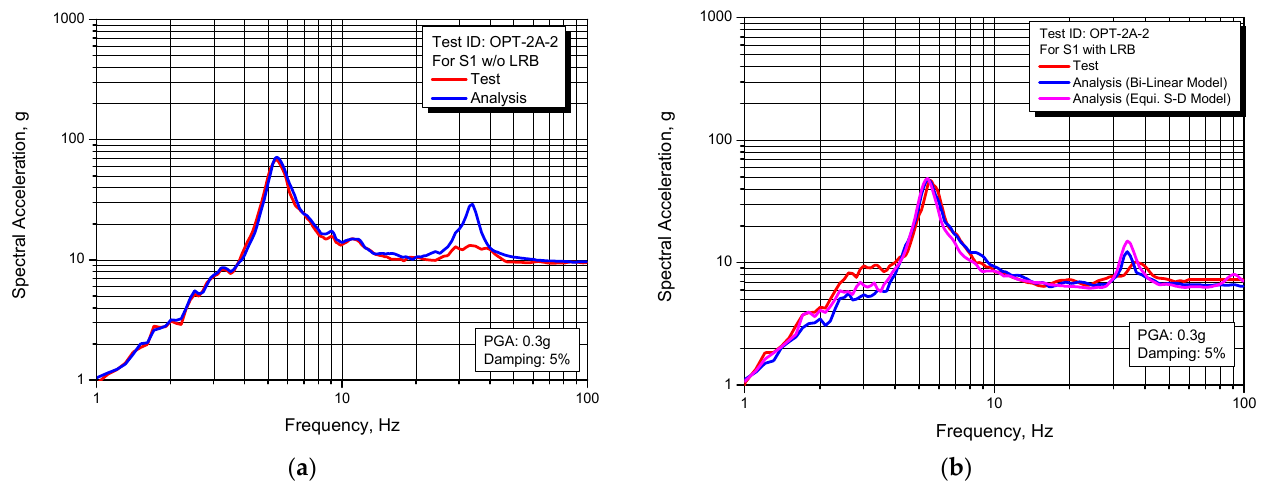
Figure 19. Comparison of response spectrum between test and analysis for S1 structure: ( a ) Non-isolated; ( b ) Seismically isolated.